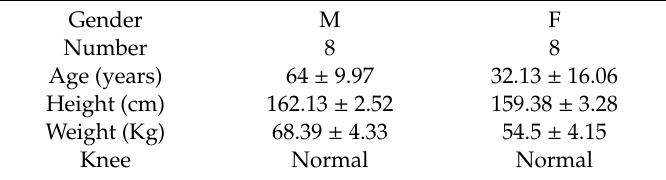
Table 3. Healthy control subjects’ characteristics.